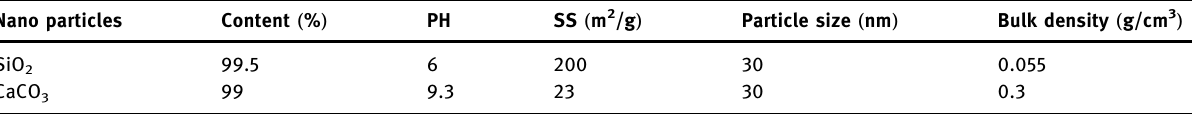
Table 3: Performance indices of nanoparticles